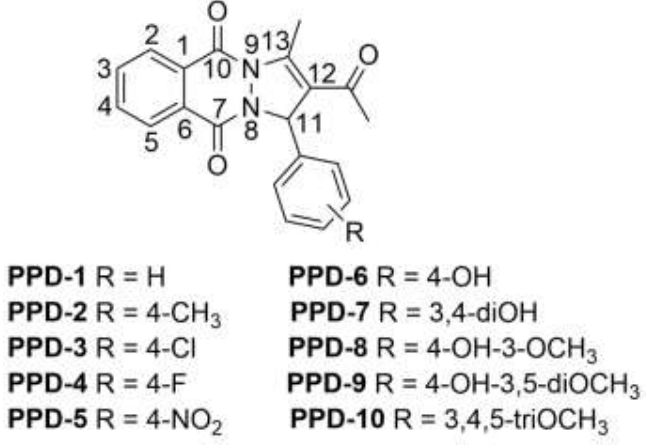
Figure 3. General structural formula of the investigated compounds PPD-1-10 with atom labeling used in Structure-based activity relationships